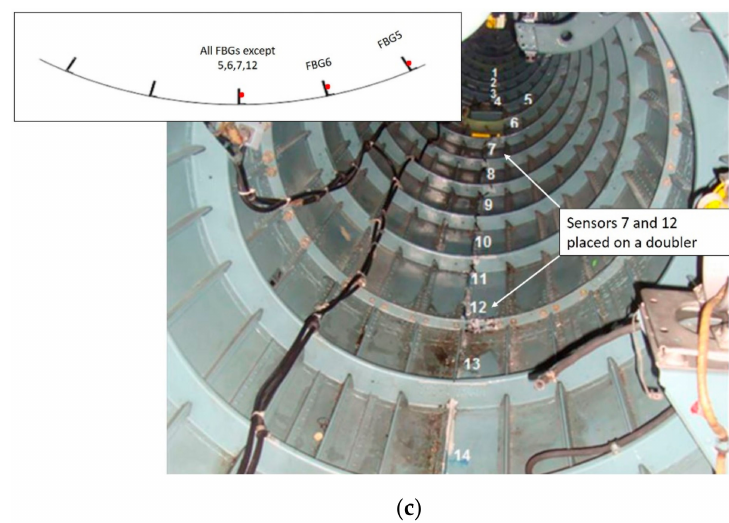
Figure 11. Sensor location for: ( a ) frame 7, ( b ) frame 10 and ( c ) tail boom.